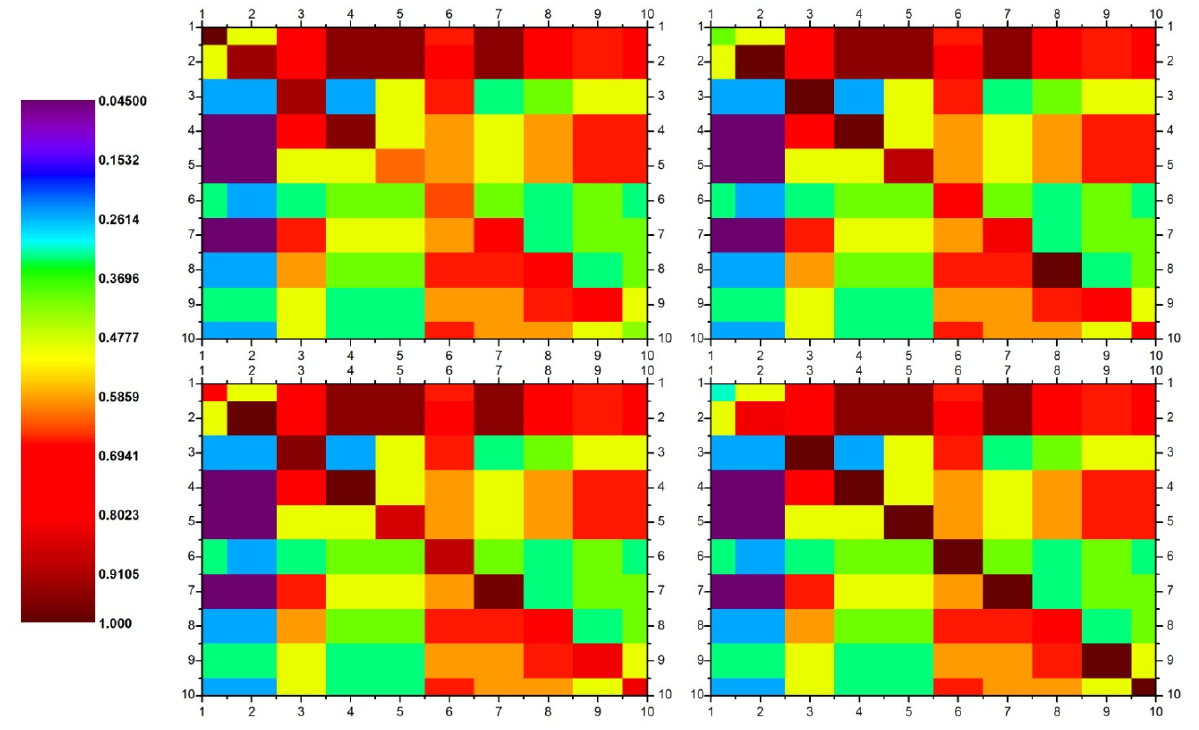
Figure 5. Rainbow color representation of decision matrices for HY-0 ( top right side), HY-30 ( top left side), HY-65 ( bottom left side), and HY-100 ( bottom right side). Table 4. Suitability index value (SIV) and ranking of hybrids.